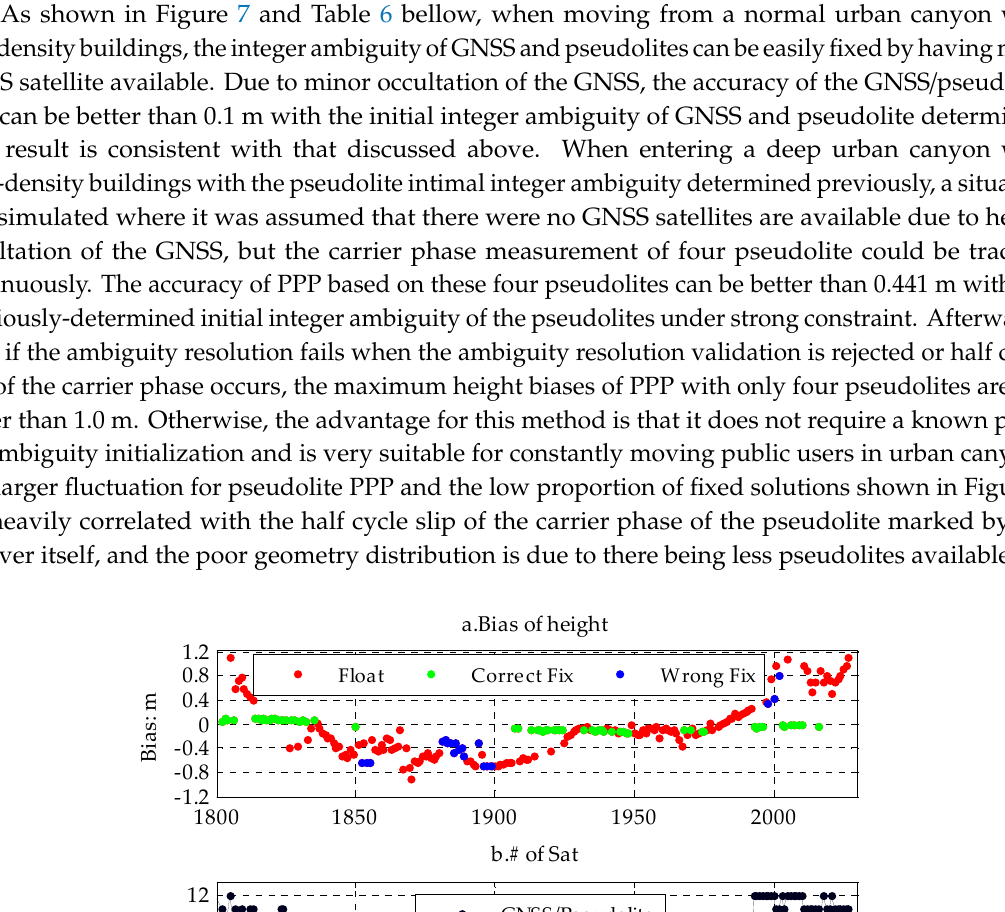
Table 6. GNSS/pseudolite PPP results based on simulation data.